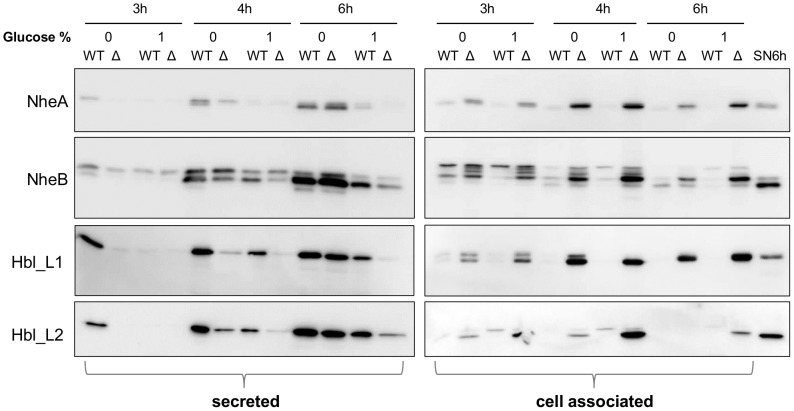
Comparison of NheA, NheB, Hbl_L1 and Hbl_L2 secretion by western-blot analysis.Western-blot assay of secreted (left) and cell associated (right) toxin components NheA, NheB, Hbl_L1 and Hbl_L2. Samples of the growth medium were taken from the wild type (WT) and the ΔsecDF mutant (Δ) from 3 h (exponential phase), 4 h (transition phase) and 6 h (stationary phase) cultures with and without added glucose. The blots are representative of at least two biological replicates. To visualize size differences between pre- and mature proteins, a supernatant wild type sample (SN6H) has also been applied to the blot showing cell associated protein.